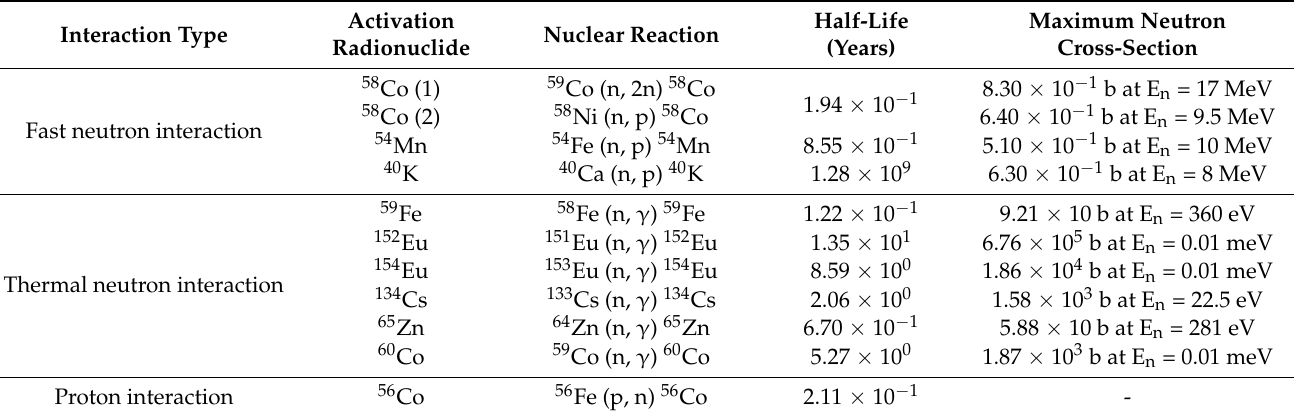
Table 3. The observed radionuclides and their nuclear reactions; cross-sections values were taken from the ENDF/VIII.0 neutron